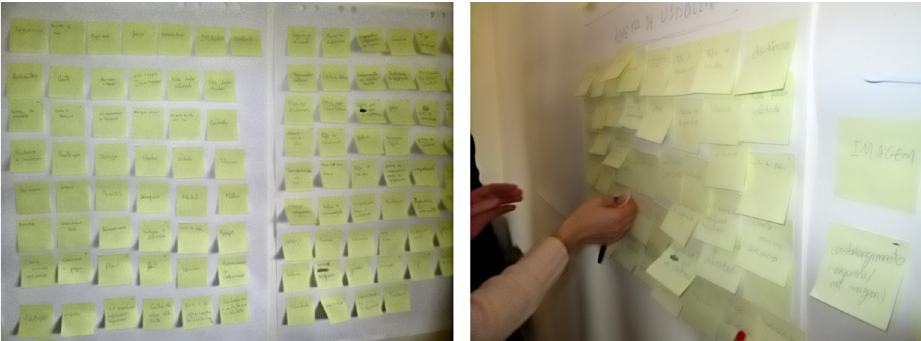
Fig. 3. Snapshots of the application of the “post-its